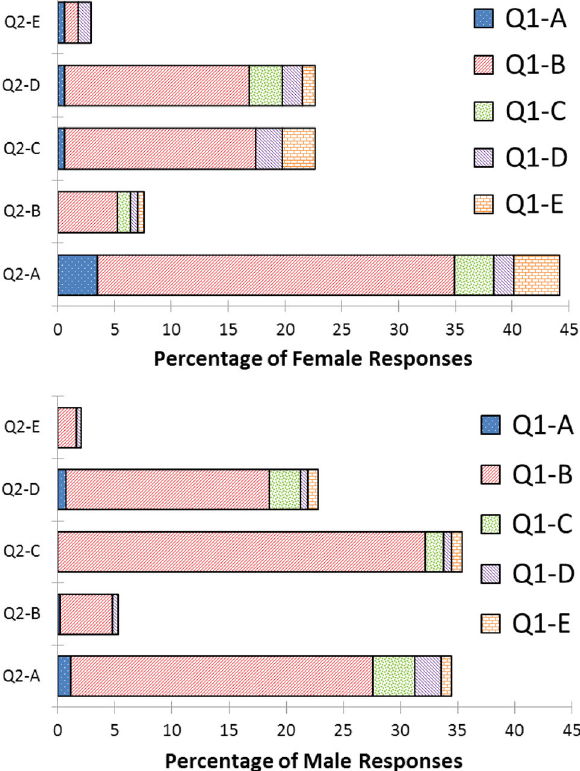
FIG. 8. Item response curves for question 2 of the 2010 ASOE, collision of two objects with same kinetic energy , for females (top) and males (bottom).